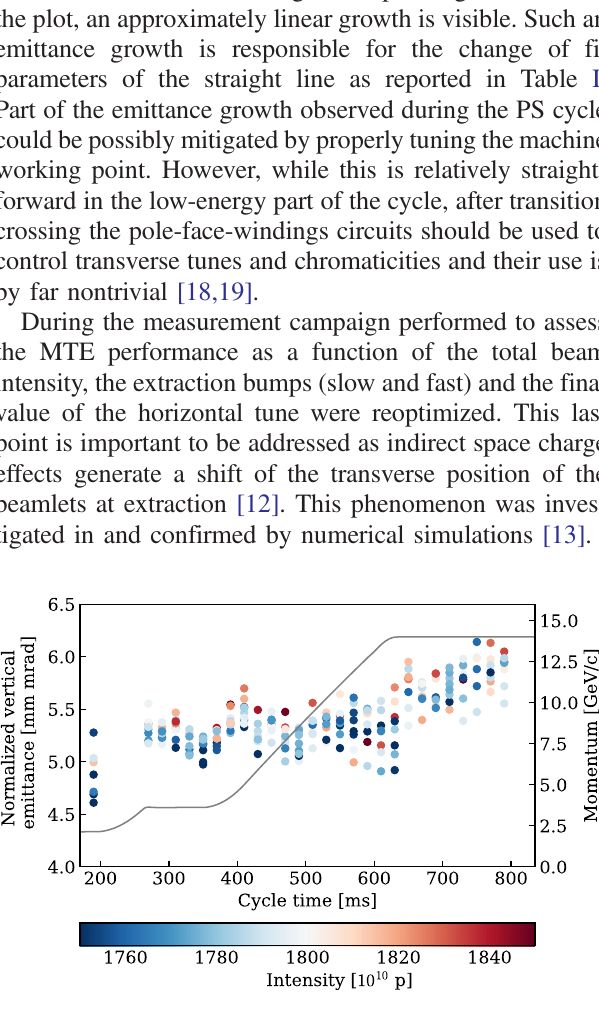
FIG. 9. Evolution of the vertical beam emittance, measured with WS85, along the PS MTE cycle. The color scale represents the typical intensity fluctuation occurring during the